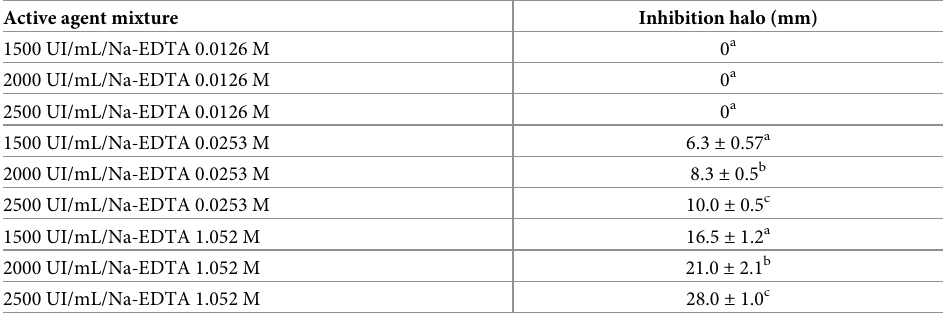
Table 1. Determination of the minimum inhibitory concentration of the nisin/Na-EDTA mixture against E . coli . �